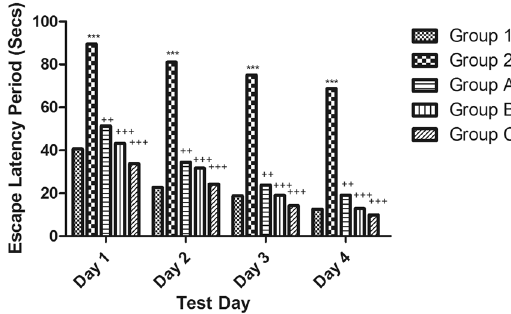
Figure 1. Effect of STZ, celecoxib and gingerol on the mean escape latency in the Morris water maze. Animals were divided into 5 groups. Group 1 received a single ICV dose of saline; then, after 2 weeks, animals were intraperitoneally injected with saline for seven days. Group 2 received a single injection of STZ (3 mg/kg, i.c.v.), and then, after 2 weeks, they were intraperitoneally injected with saline for 7 days. Group A was injected with STZ (3 mg/kg, i.c.v.) once, and after 2 weeks, they were injected with celecoxib (30 mg/kg, i.p.) for 7 days. Group B received a single injection of STZ (3 mg/kg, i.c.v.), and after 2 weeks, they were injected with gingerol (10 mg/kg/day, i.p.) for 7 days. Group C was injected with STZ (3 mg/kg, i.c.v.) once, and after 2 weeks, they were injected with gingerol (20 mg/kg/day, i.p.) for 7 days. Animals from groups A, B, and C were subjected to the behavioral tests after the 3 rd week of injections. Each result represents the mean value for 10 mice ± SE of the mean. Statistical analysis was carried out by one-way ANOVA followed by the Tukey-Kramer multiple comparison test with the aid of GraphPad Prism Software version 5. *** Significantly different from the normal group P < 0.001. ++ Significantly different from the STZ group P < 0.01. +++ Significantly different from the STZ group P <